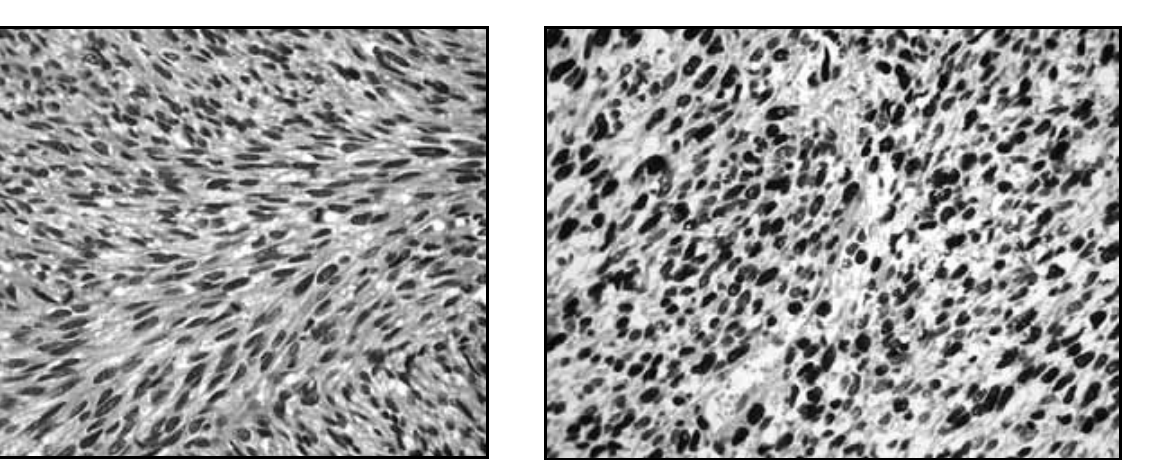
Figura 2 – Microscopia: padrão de crescimento fusocelular com feixes curtos e alta taxa mitótica (HE, 400×) HE: hematoxilina e eosina.